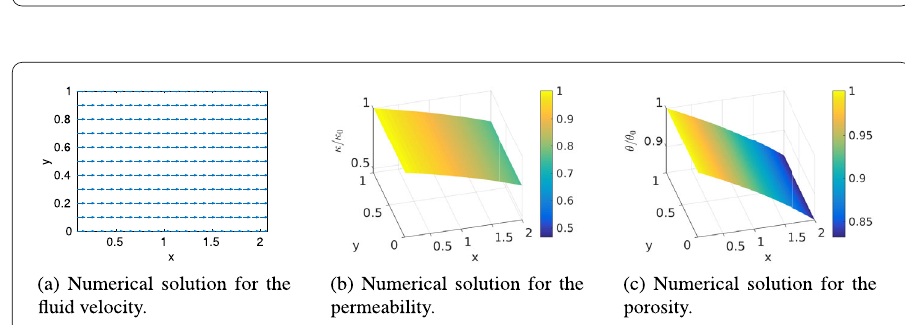
Figure 12 Numerical solutions for the fluid velocity, the permeability and the porosity, at time t = 300, obtained using the network-inspired relation with p c =